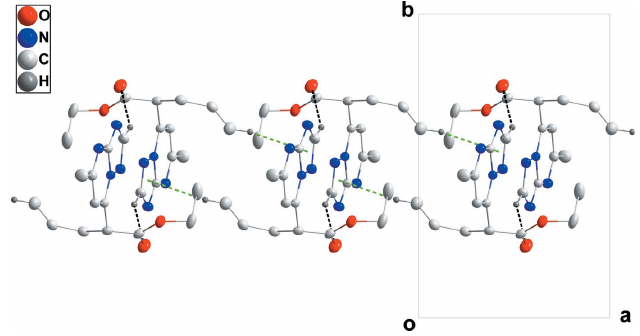
Figure 2 A portion of one chain viewed along the c -axis direction. C—H (cid:2)(cid:2)(cid:2) O hydrogen bonds and C—H (cid:2)(cid:2)(cid:2) (cid:2) (ring) interactions are shown, respectively, by black and green dashed lines.